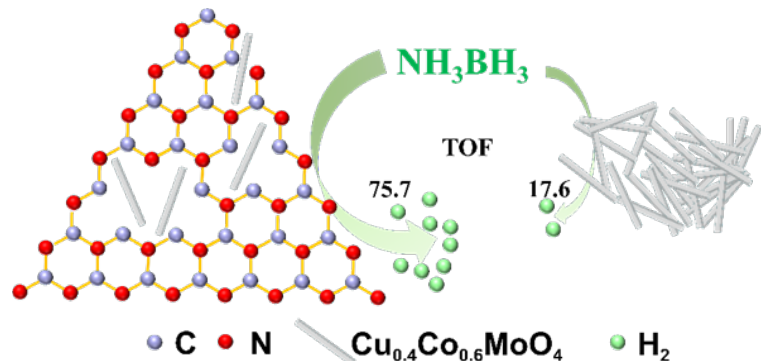
Figure 6. Scheme of the catalytic properties of bulk Cu 0.4 Co 0.6 MoO 4 and Cu 0.4 Co 0.6 MoO 4 / g-C 3 N 4 . Cu x Co 1– x MoO 4 / g-C 3 N 4 ( x = 0, 0.2, 0.4, 0.6, 0.8, 1) samples to test their catalytic performance, shown in Figure 7. No matter the value of x, Cu x Co 1– x MoO 4 / g-C 3 N 4 samples were active in the hydrolysis of